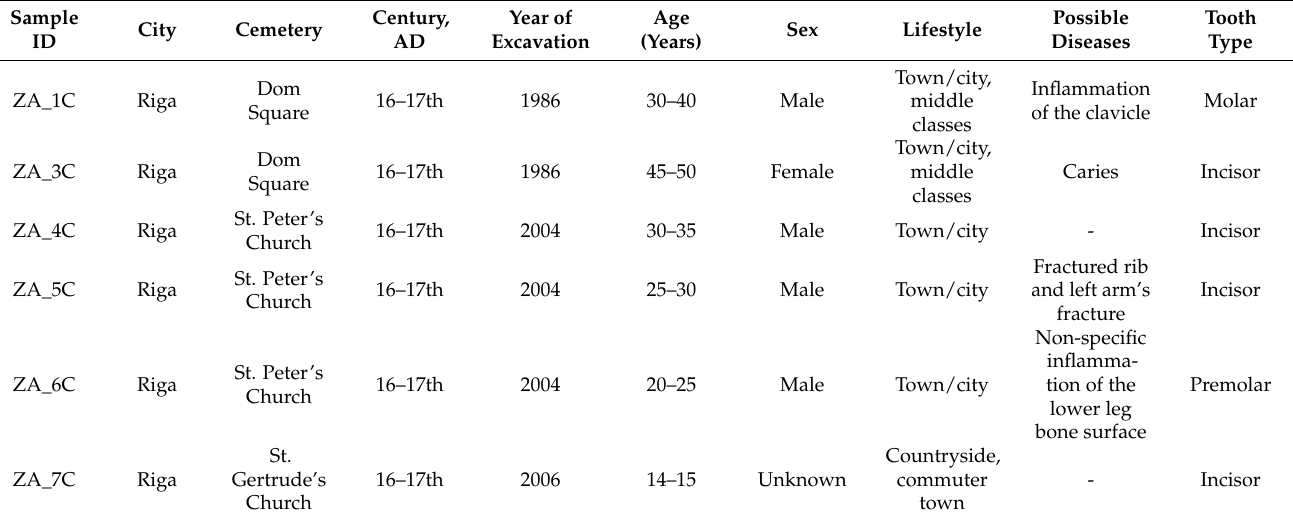
Table 1. Characteristics of archaeological